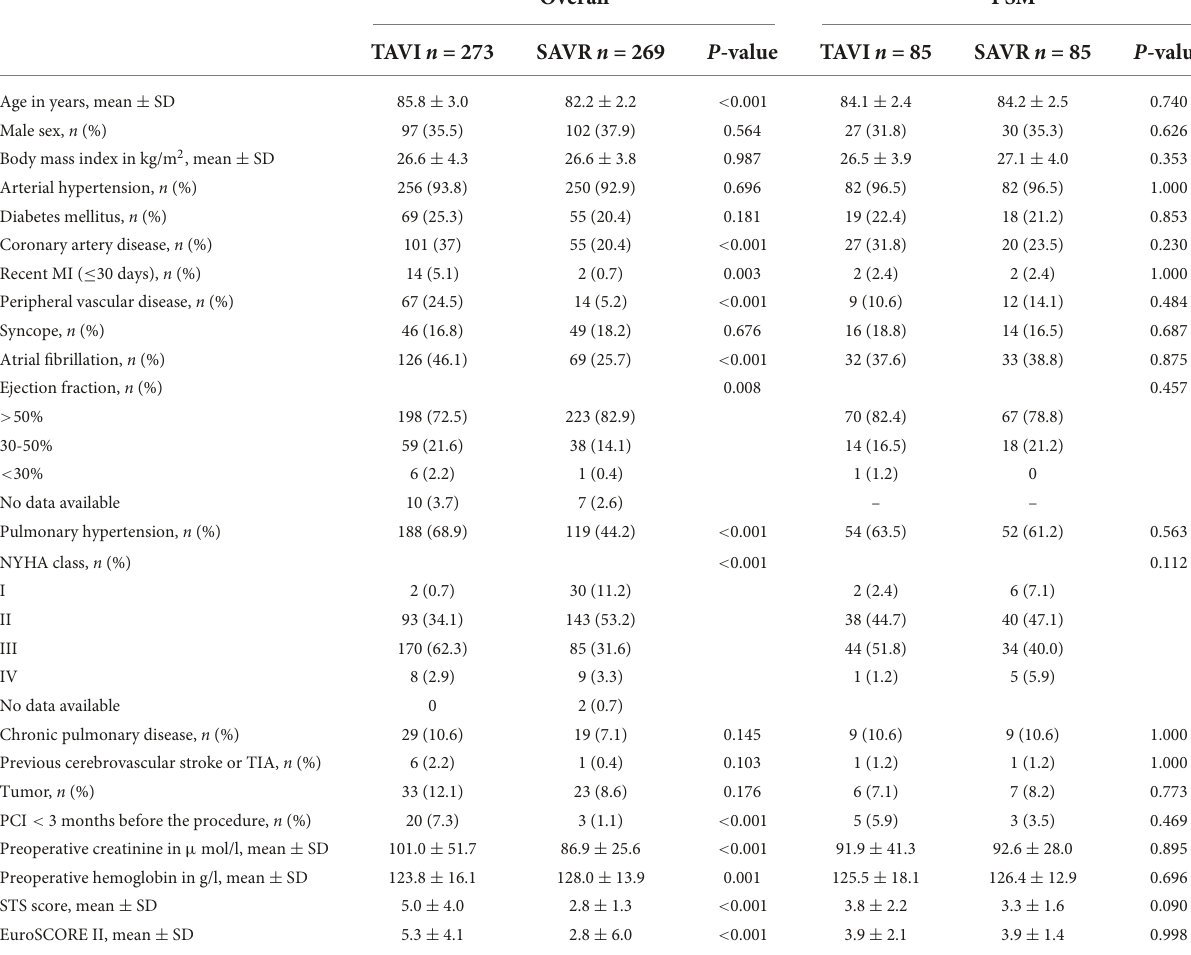
TABLE 1 Patient baseline